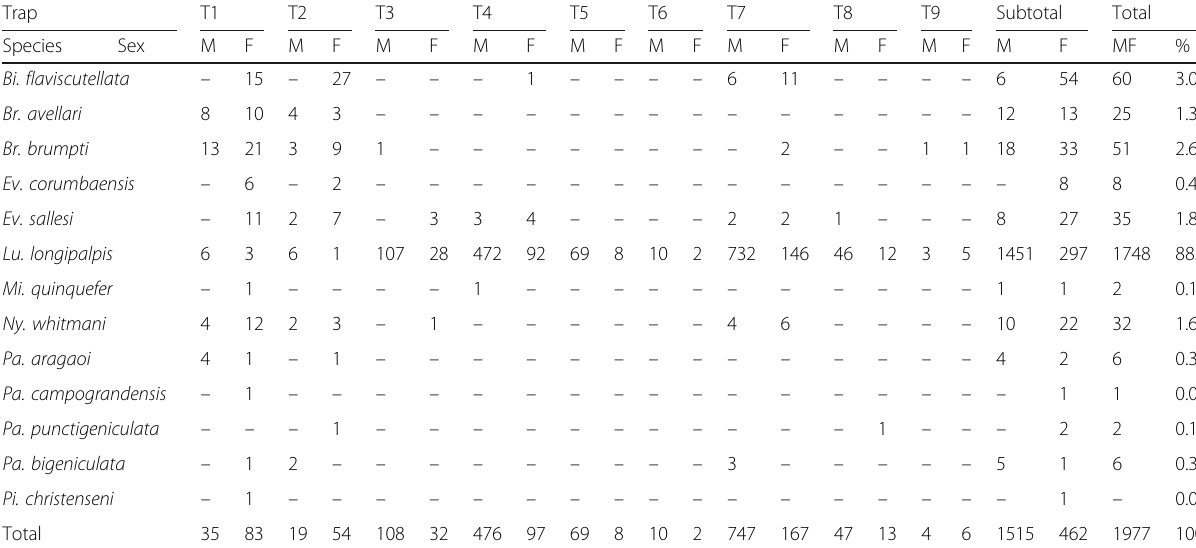
Table 1 Phlebotomines distribution according to species, sex and the ecotopes where the traps were installed in Bonito municipality, Mato Grosso do Sul state, Brazil, from October 2005 to July 2006 Trap T1 T2 T3